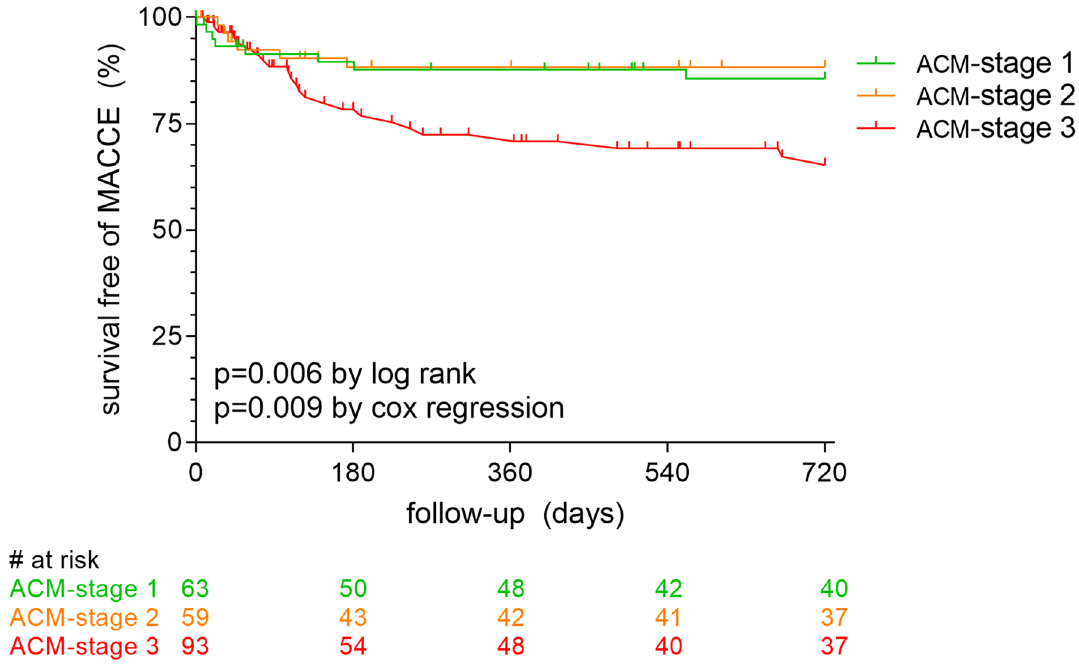
Figure 4. Future MACCE and electrocardiographic evidence of ACM. Kaplan–Meier-curves for survival free of MACCE (stroke or transient ischemic attack, myocardial infarction, hospitalization for heart failure or all-cause death) in patients with ACM-stages 1 (no ACM, in green), 2 (moderate ACM, in orange) or 3 (extensive ACM, in red). ACM atrial